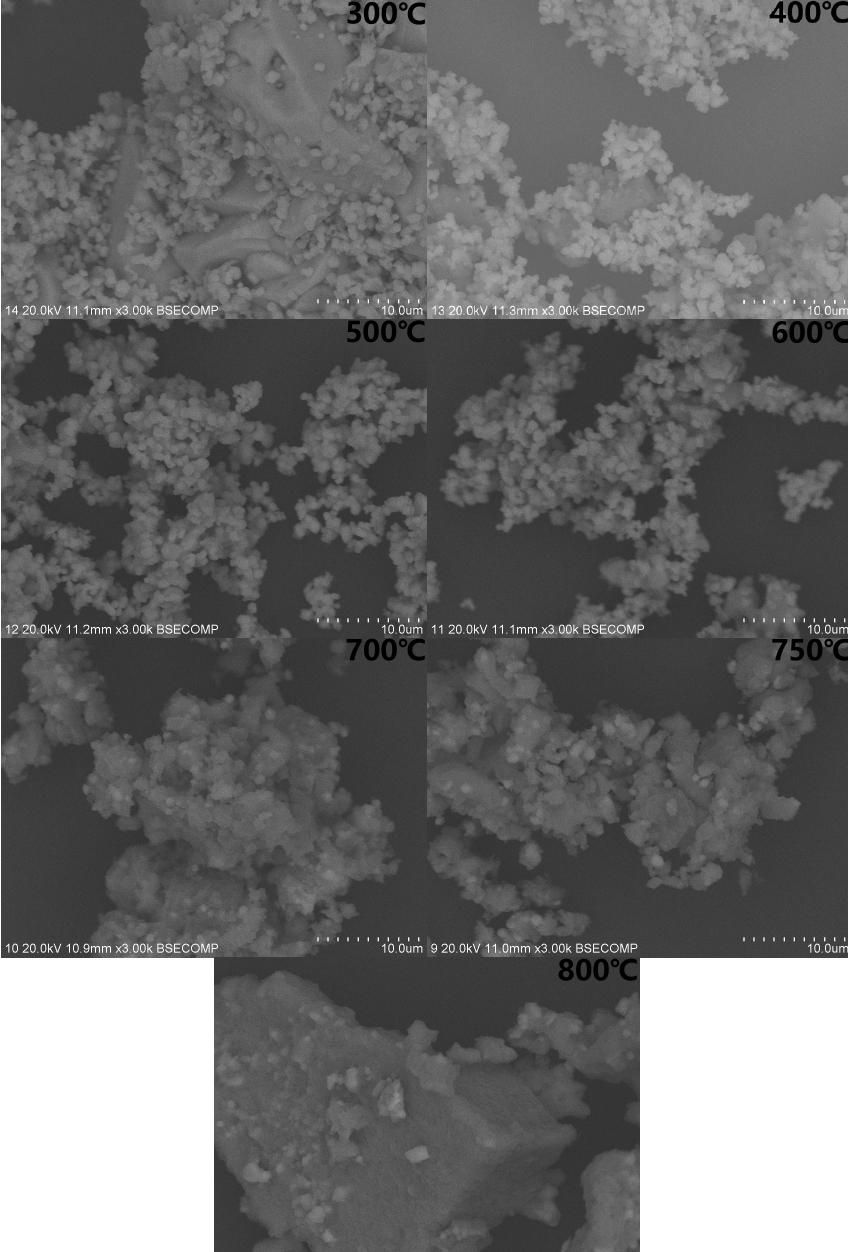
Figure 6. The SEM images of a sample of mixed Cr 2 O 3 and Na 2 CO 3 in a 1:1 ratio, at different temperatures for 1 h. temperatures for 1